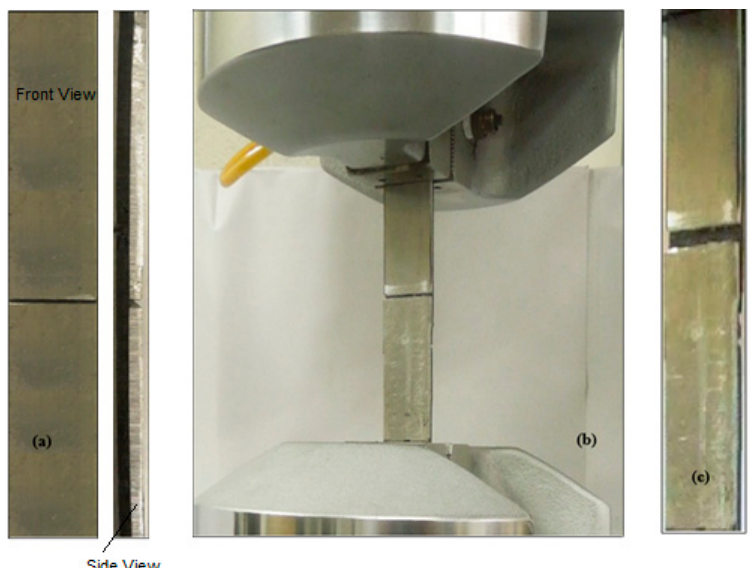
Figure 8. ( a ) Double notch shear test coupon; ( b ) coupon secured in the MTS testing machine; ( c ) damaged test coupon.